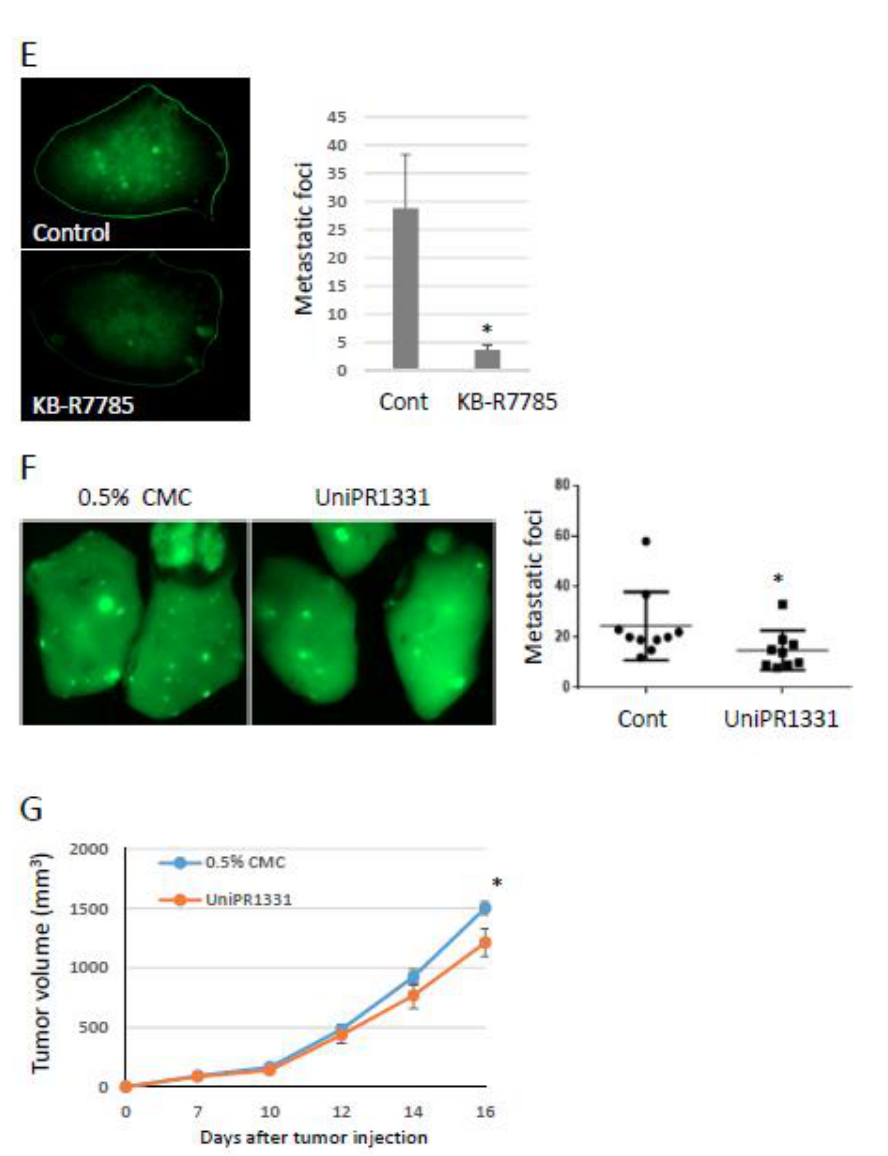
Figure 4. The effects of inhibitors against the ADAM12/ephrin-A1/EphAs axis on tumor growth and metastasis. ( A ) Effects of KB-R7785 on cell viability in vitro. MTT assay was performed. KB- R7785 significantly decreased cell viability. (* p < 0.05, ** p < 0.01) ( B ) Effects of KB-R7785